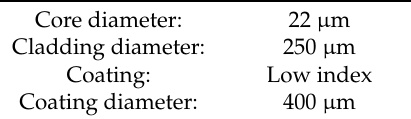
Table 6. Geometry parameters of the self-made double-clad fiber [7].